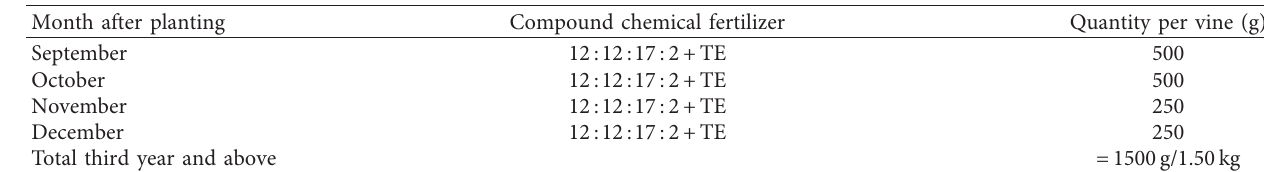
Table 2: Rate of compound chemical fertilizer application for mature vines [3, 12]. Month after